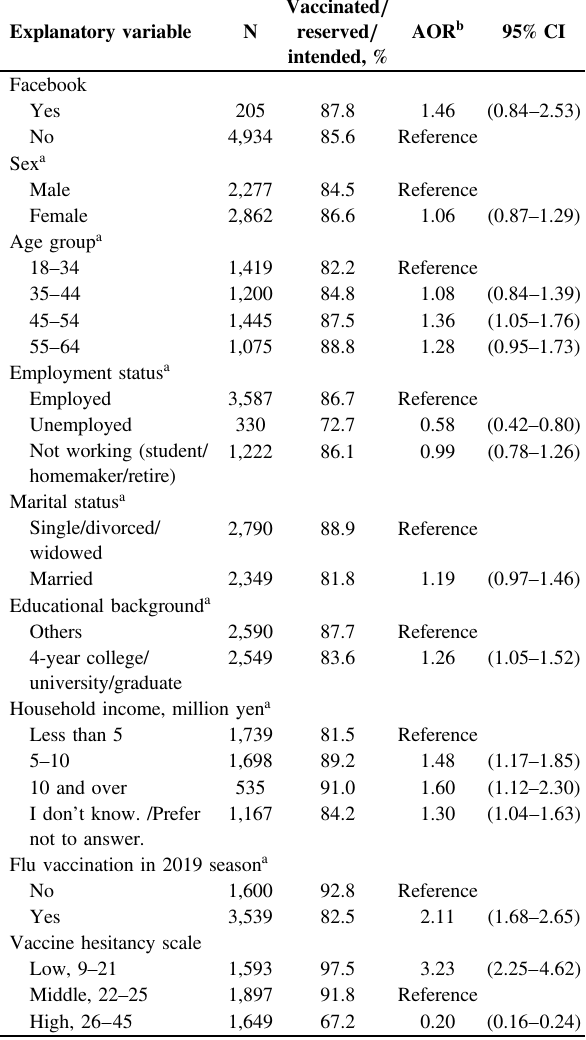
Table 1 Prevalence of COVID-19 vaccine uptake rate by each category, and its relationship to information source